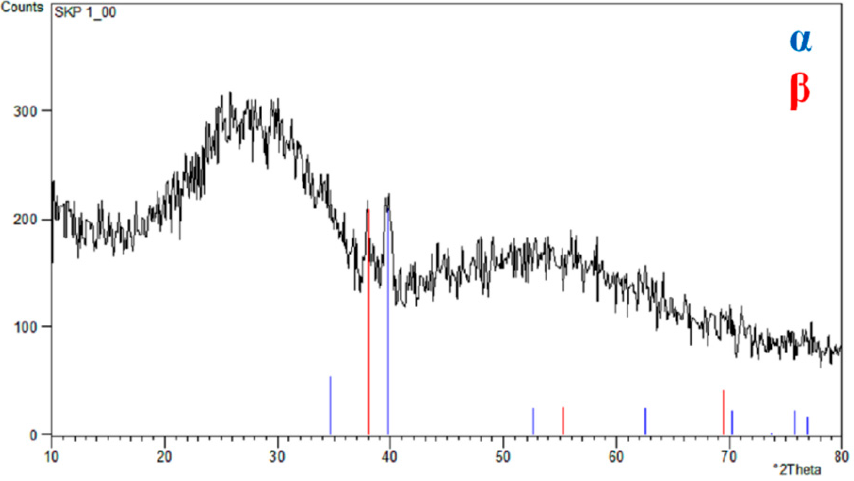
Figure 4. GIXD pattern of Ti–13Zr–13Nb after anodization in 1 M (NH 4 ) 2 SO 4 with 2 wt.% NH 4 F [14]. A new generation of biomedical titanium alloy was selected for research in this